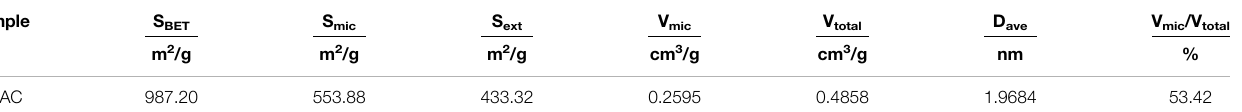
TABLE 1 | Pore structure parameters of WIRAC.